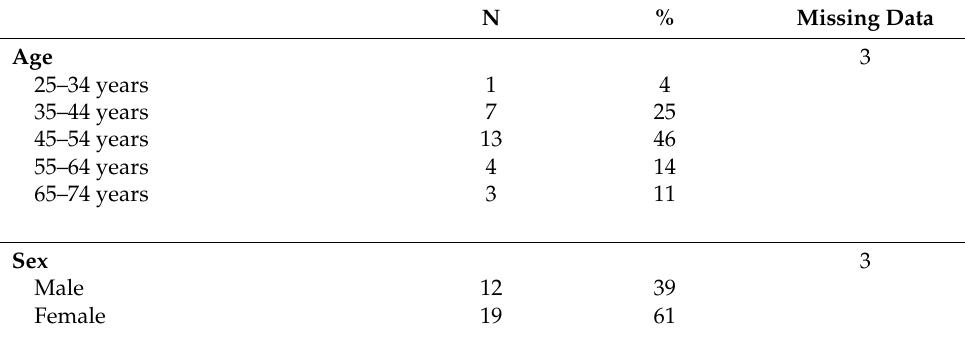
Table 1. Overview of the characteristics of the 31 participating experts (for full socio-demographic table—see Supplementary Table